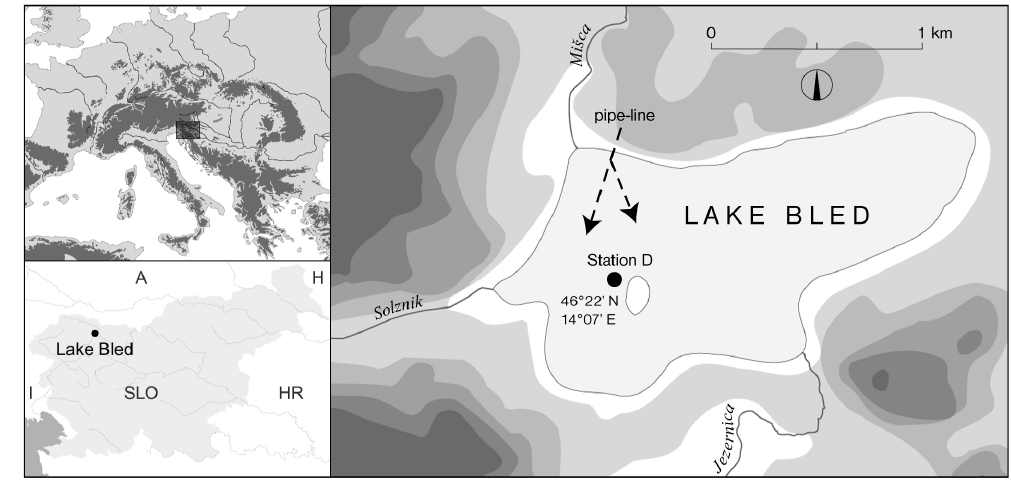
Figure 1 Fig. 1. Location of Lake Bled with sampling point D, the deepest Western Basin,